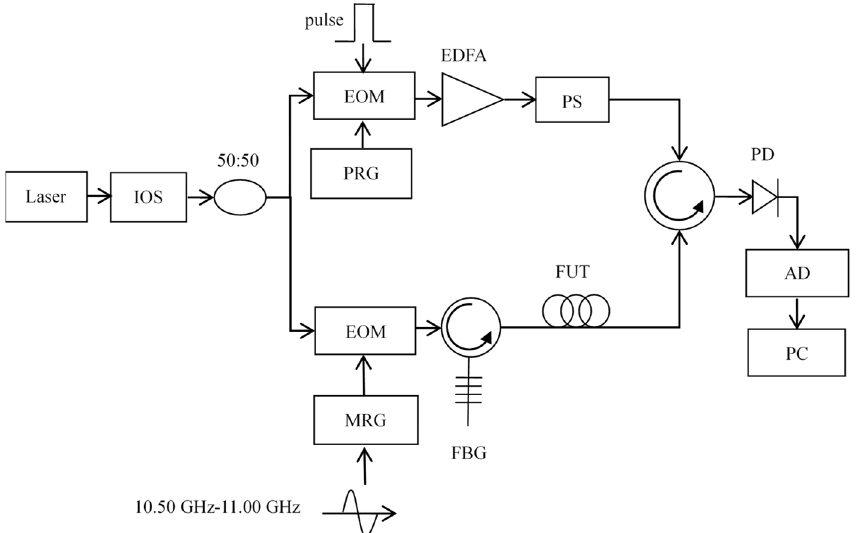
Figure 7. BOTDA experimental setup. ISO: Isolator, PRG: Pulse pattern generator. EOM: Electro- optic modulator PS: Polarization scrambler, PD: Photodetector, MRG: Microwave generator, FBG: Fiber grating filter, FUT: Fiber under test, AD: Analog-digital converter, EDFA: Erbium-doped fiber amplifier.